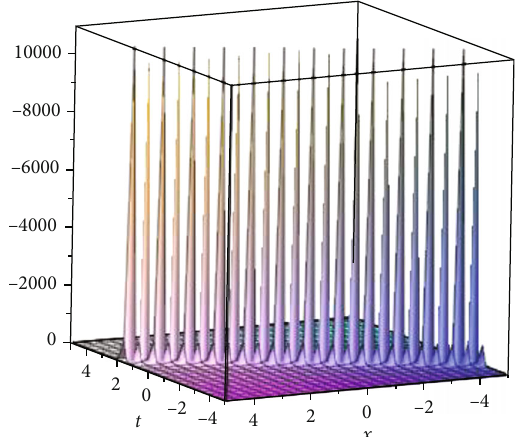
Figure 1: Perspective view of 3D graph of W values ω = 2 , z 0 = 0 : 5 , μ = 1 , k = 1 , and f = 1 represents the exact solutions.